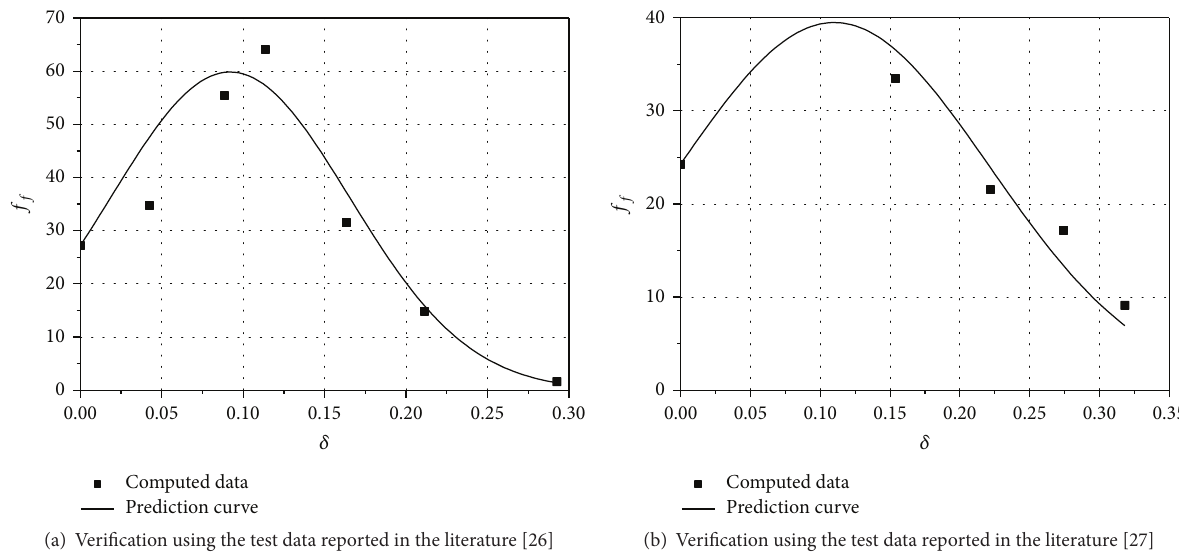
(b) Verification using the test data reported in the literature [27] Figure 13: Verification of (9) proposed in this study by the existing experimental